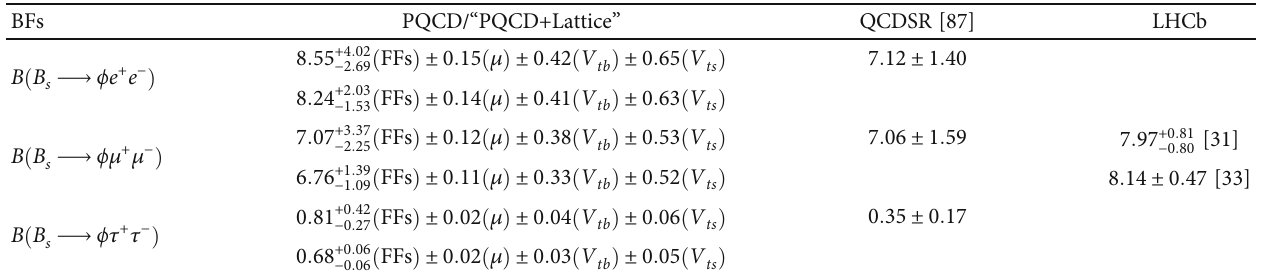
⟶ ϕ ℓ + ℓ − Þ (in units of 10 − 7 ) in the PQCD (the fi rst row) and “ PQCD Table 6: Theoretical predictions for the total branching fractions B ð B s +Lattice ” (the second row) approaches. As a comparison, we also list the LHCb measured value for muon channel corresponding to an integrated luminosity of 3 f b − 1 [31] and 9 f b − 1 [33] and the QCDSR predictions for all three channels